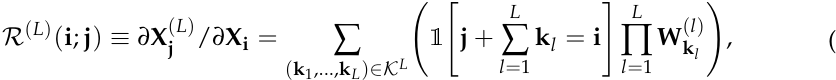
Figure 3. Graphical representation of the receptive field. ( a ) Considers a unique input layer to which a 3 × 3 kernel is applied with a stride of 1. The color map indicates the number of times the kernel has been applied on each feature (i.e., the darker the color, the more kernel applications). The number of times the kernel has been applied over a feature is also included. For instance, the edge pixels are used between 0 and 3 times, while the center pixels are used 9 times. ( b ) Receptive field of an output feature obtained by a CNN composed of two 3 × 3 convolution layers (in red) and a 2 × 2 pooling layer (in